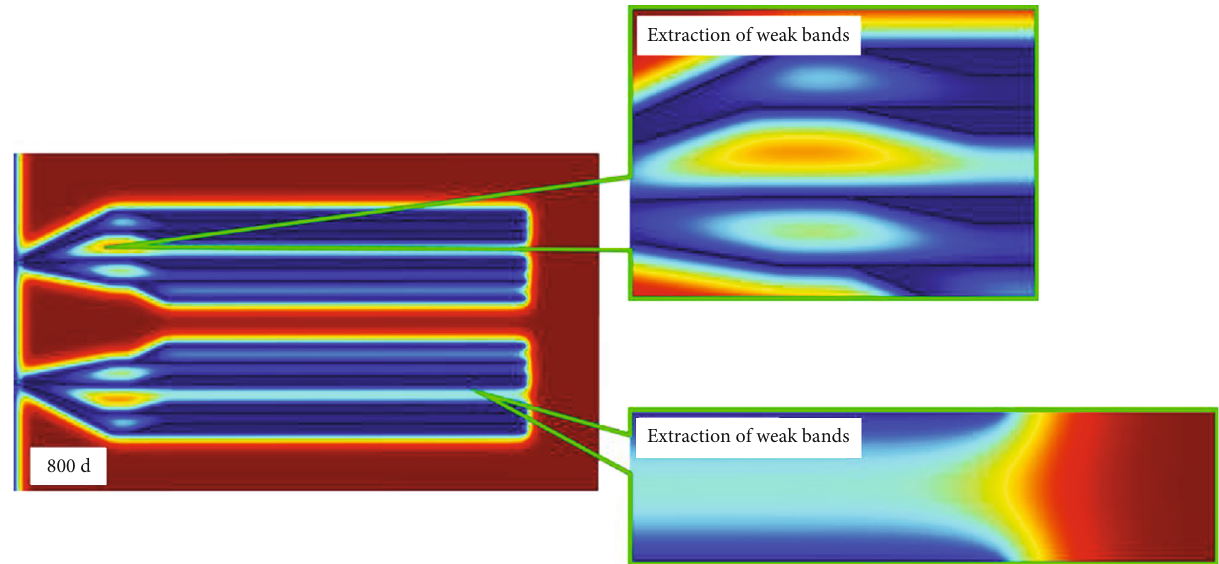
Figure 4: Weak zone of directional drilling